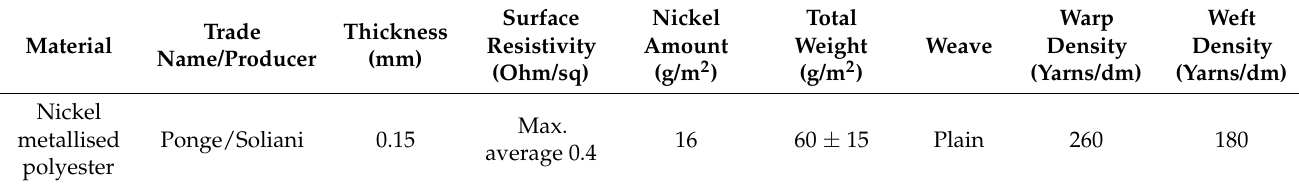
Table 1. The basic parameters of Ponge fabric are used as electro-conductive paths.